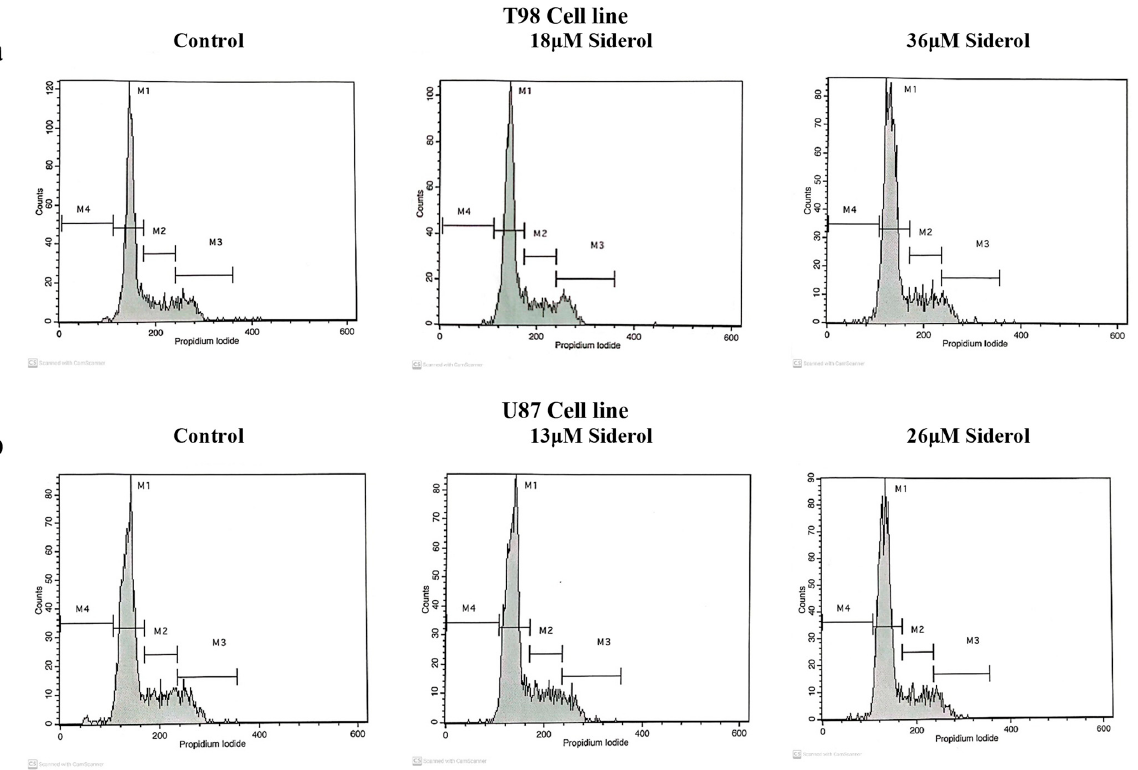
Figure 5. Histogram representation of cell-cycle distribution in T98 ( a ) and U87 ( b ) cell lines after treatment with siderol in concentrations of IC50 and twice IC50 values.